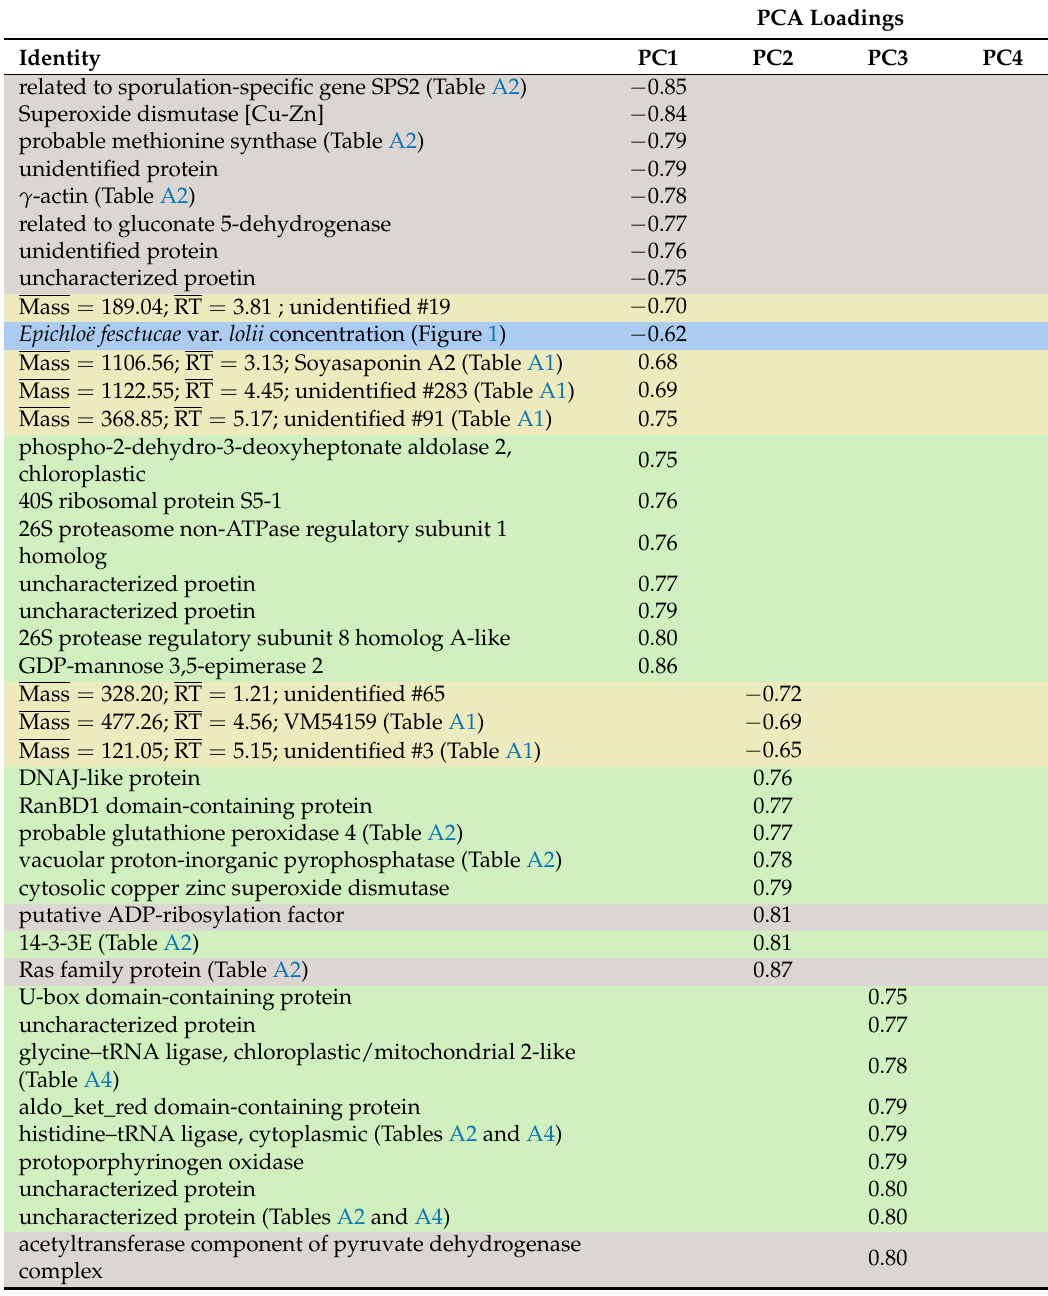
Table A5. Integrated OMICs Principal Components Analysis. Shown are the metabolites and proteins that “load heavily” onto the first four principal component axes. “Heavy” loadings are defined here as | x | ≥ 0.75 for the proteins and | x | ≥ 0.65 for the metabolites. Fungal derived proteins are highlighted in pale brown, plant derived proteins are highlighted in pale green, metabolites are highlighted in pale yellow, and the concentration of the Epichloë endophyte is highlighted in pale blue. Where metabolites or proteins are important in other analyses they are cross referenced to the relevant